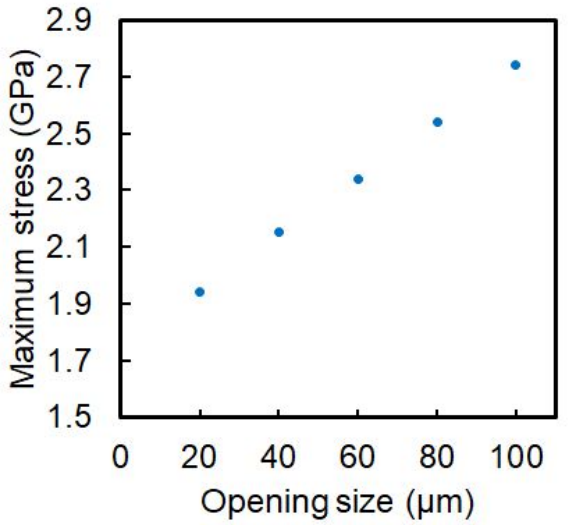
Figure 3. Maximum stress as a function of opening size in a 10-nm-thick Si 3 N 4 membrane.